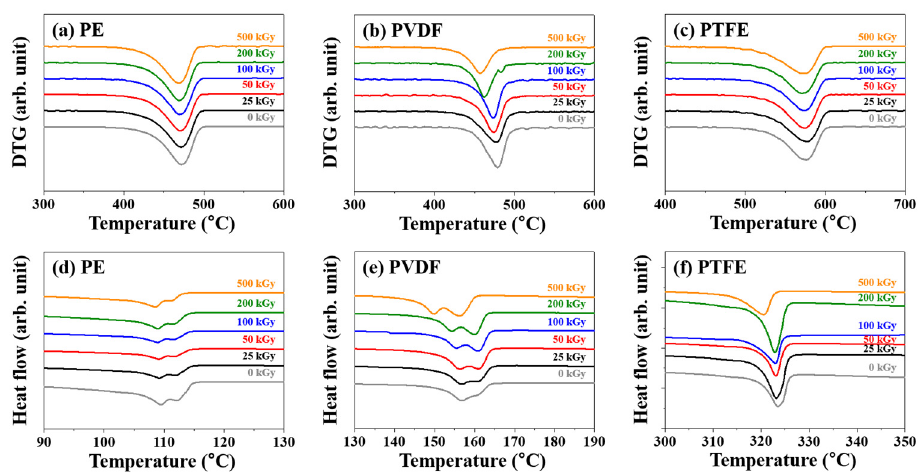
Figure 5. DTG curves of ( a ) PE, ( b ) PVDF, and ( c ) PTFE; DSC curves of ( d ) PE, ( e ) PVDF, and ( f ) PTFE.